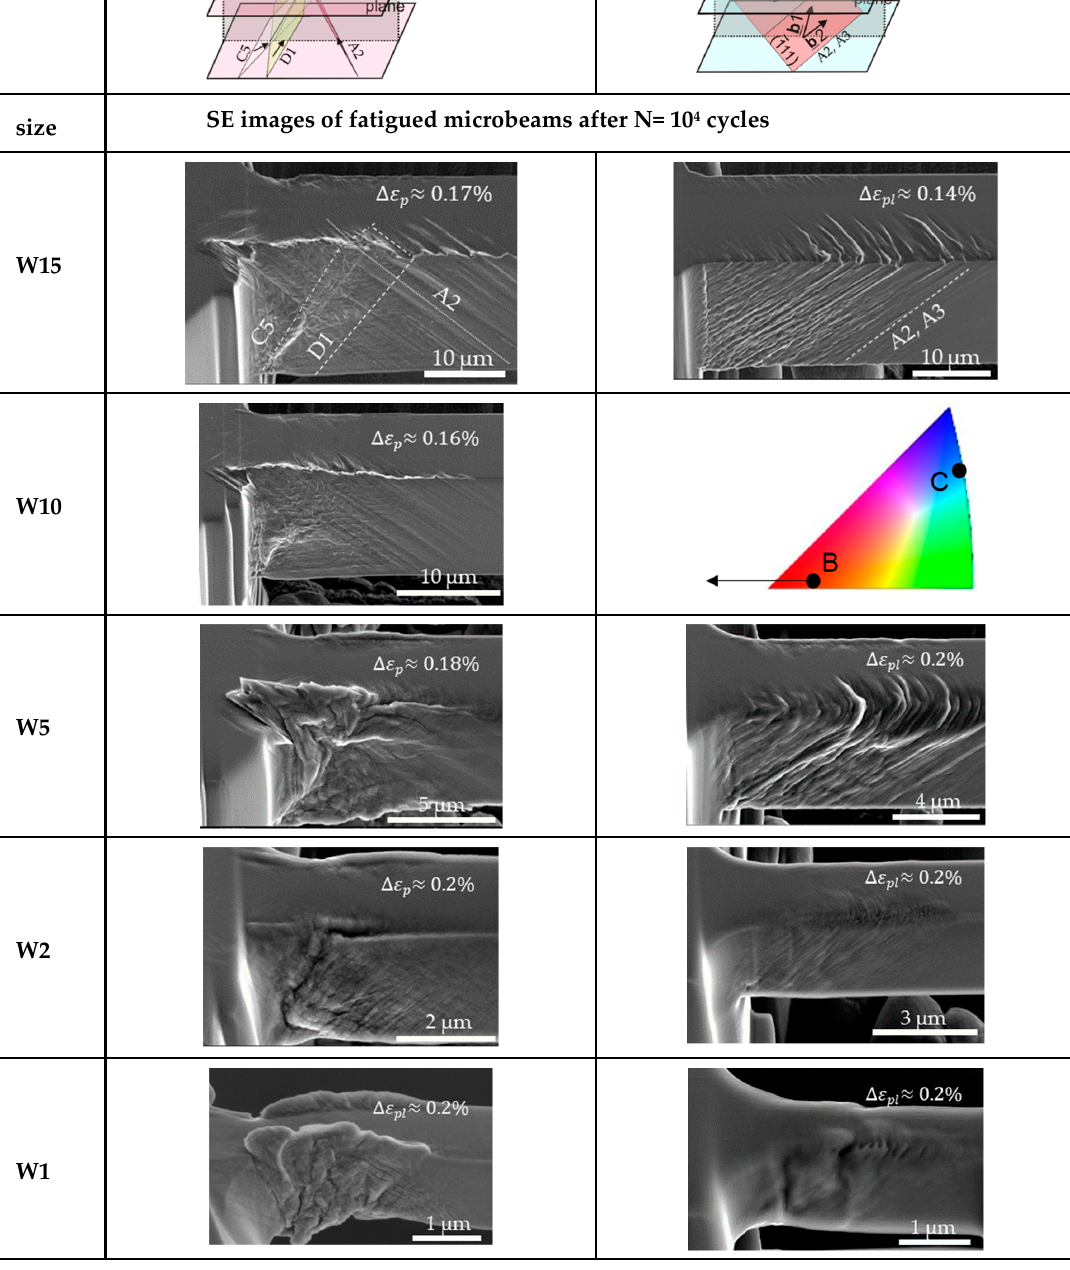
Figure 5. Evolution of the surface roughness of microbeams with different sizes (from 15 to 1 µm) after 10 4 cycles. Left column: Beams with the orientation B (critical double slip); right column: Beams with the orientation C (coplanar double slip). Sketched glide systems A2, D1, and C5 (orientation B), and A2 and A3 (orientation C) with the largest Schmid factor are on the first row for more clarity.